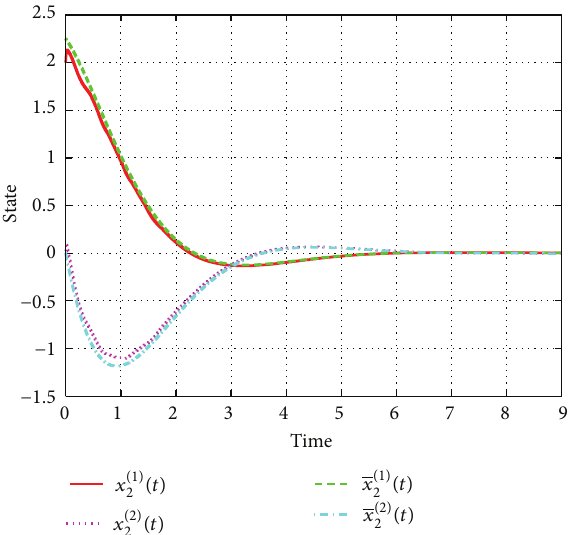
Figure 2: Time histories of 𝑥 2 (𝑡) and 𝑥 2 (𝑡)